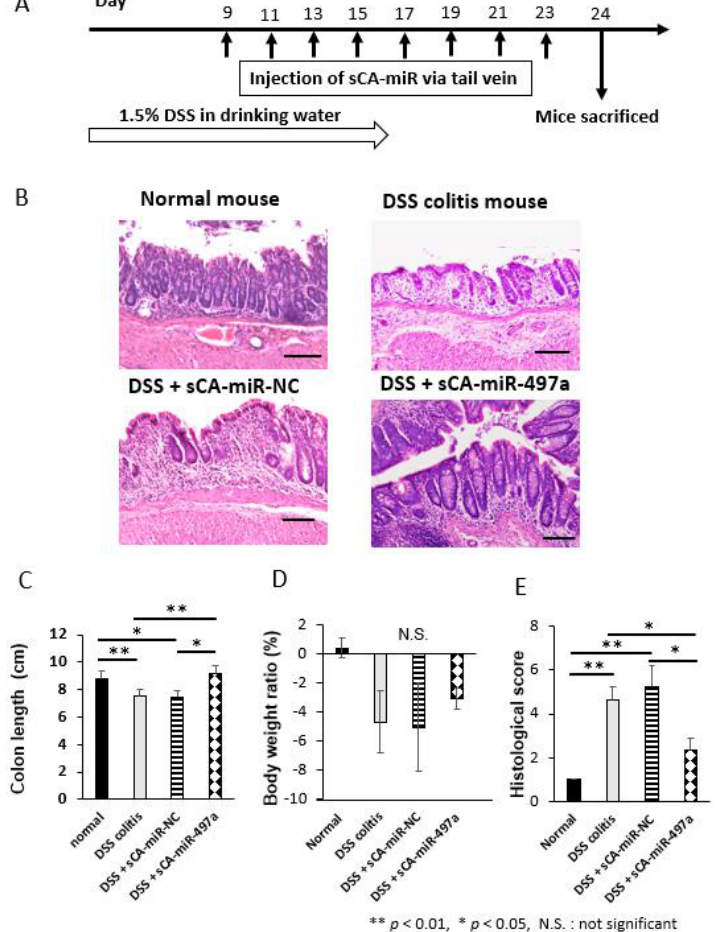
Figure 7. Therapeutic experiment of DSS-induced colitis by intravenous injection of sCA-miR-497a-5p. ( A ) Induction of mouse colitis by 1.5% DSS in drinking water and the therapeutic schedules are shown here. Normal mice ( n = 3), DSS-treated mice ( n = 3), DSS and sCA-miR-NC-treated mice ( n = 4), DSS and sCA-miR-497a-5p-treated mice ( n = 3). ( B ) H&E staining of distal colon in each group. The mucosal structure was destroyed and many inflammatory cells were noted in DSS-treated mice or DSS and sCA-miR-NC-treated mice. By contrast, DSS and sCA-miR-497a-5p-treated mice had the notable therapeutic effect. Scale bars, 100 μm for each. ( C ) The colon length was significantly longer in mice treated with DSS and sCA-miR-497a-5p as compared to those treated with DSS alone or DSS and sCA-miR-NC (** p < 0.01, * p < 0.05, DSS alone vs. DSS and miR-497a-5p, p = 0.002; DSS and miR- NC vs DSS and miR-497a-5p, p = 0.022). ( D ) There was no significant difference in body weight loss among the DSS-treated groups. ( E ) Significantly worse histological scores in mice treated with DSS alone or DSS and sCA-miR-NC were noted, whereas sCA-miR-497a-5p treatment significantly im- proved the histological damages (** p < 0.01, * p < 0.05, DSS alone vs DSS and miR-497a-5p, p = 0.046, DSS and miR-NC vs DSS and miR-497a-5p p = 0.034).